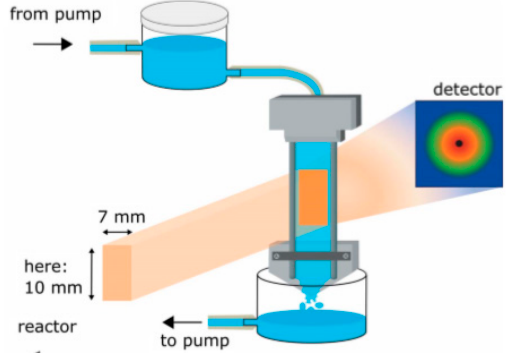
Figure 13. Container-less measuring device. A continuous stream of liquid is spread out by a nozzle between vertical wires. The free-standing film can be approximately matched to the size of a conventional neutron beam. Not shown is the bag filled with inert gas surrounding the system that is used to avoid the sample interacting with air moisture, resulting in an altered H-D ratio [121].